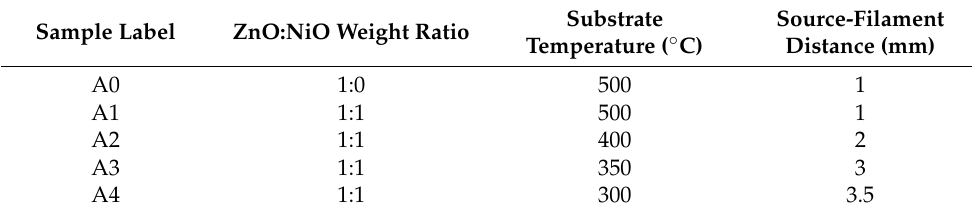
Table 1. Samples labels and deposit temperatures. All the samples were deposited for 1 min using an H 2 flow of 50 sccm. The source-filament distance was 2 mm, constant in all the deposits. The variation of the filament-substrate distance produces a different substrate temperature (deposit temperature)